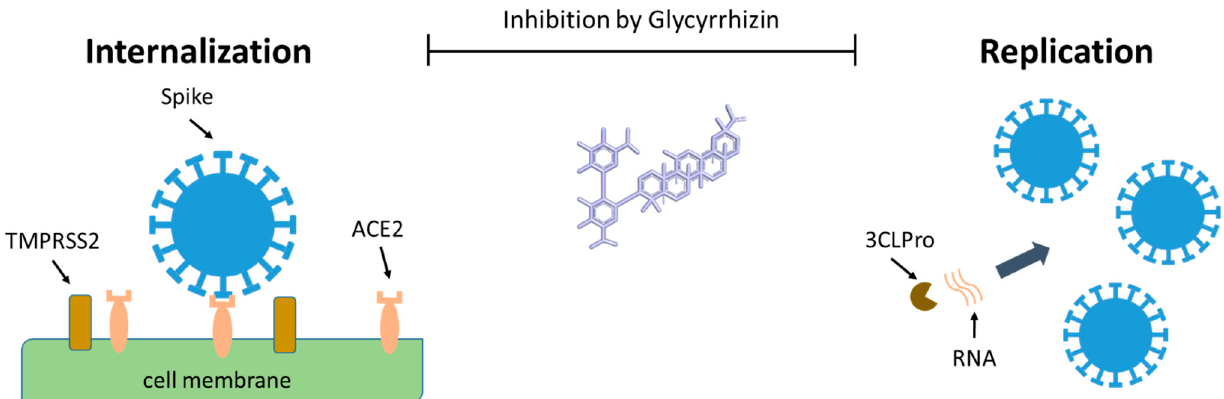
Figure 3. The possible effects of glycyrrhizin on the internalization of the SARS-CoV-2 virus in the host cell, and its replication. Created with BioRender.com, accessed on 18 March